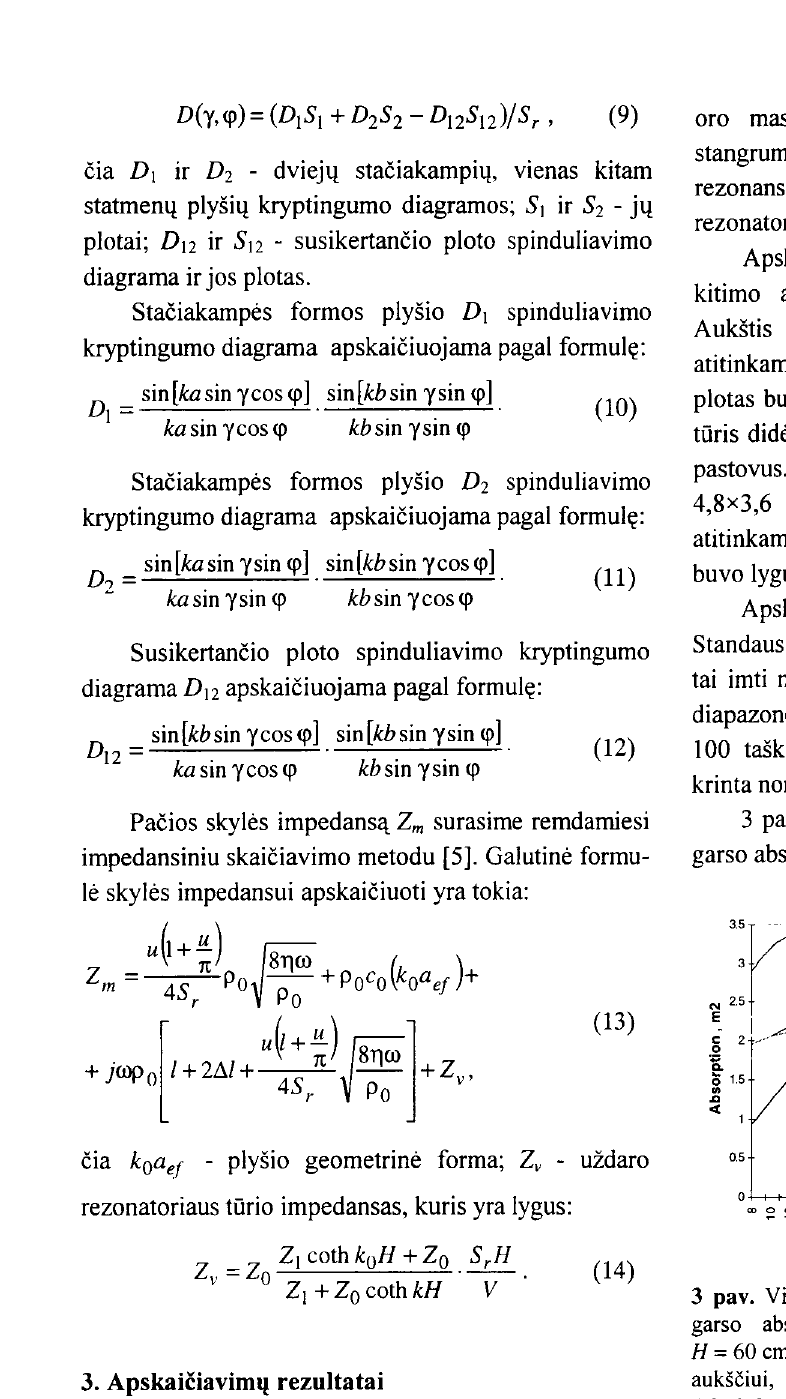
statmenl! plysil! kryptingumo diagramos; sl ir s2 - jl! plotai; D 12 ir S 12 - susikertancio ploto spinduliavimo diagrama ir jos plotas.